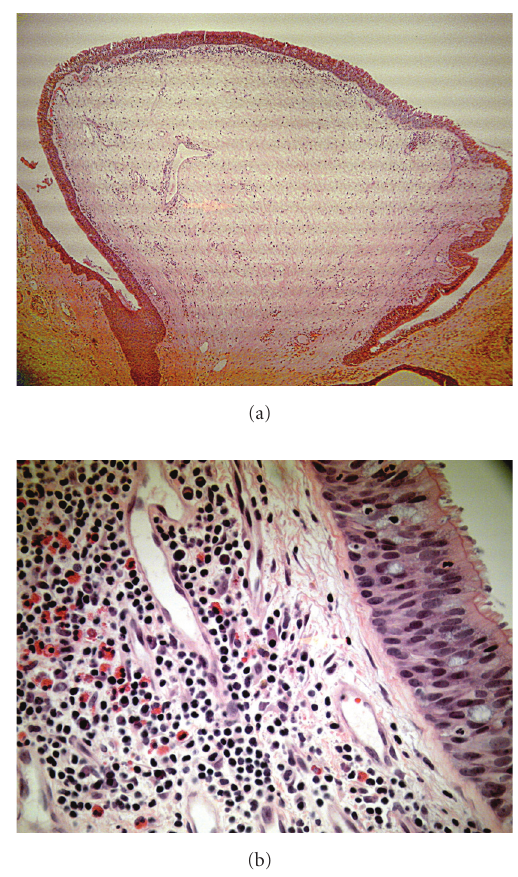
Figure 2: Low-power histopathology of the inflammatory otic polyp (a) with high-power (b) demonstration of eosinophils underlying surface pseudostratified columnar epithelium with cilia.